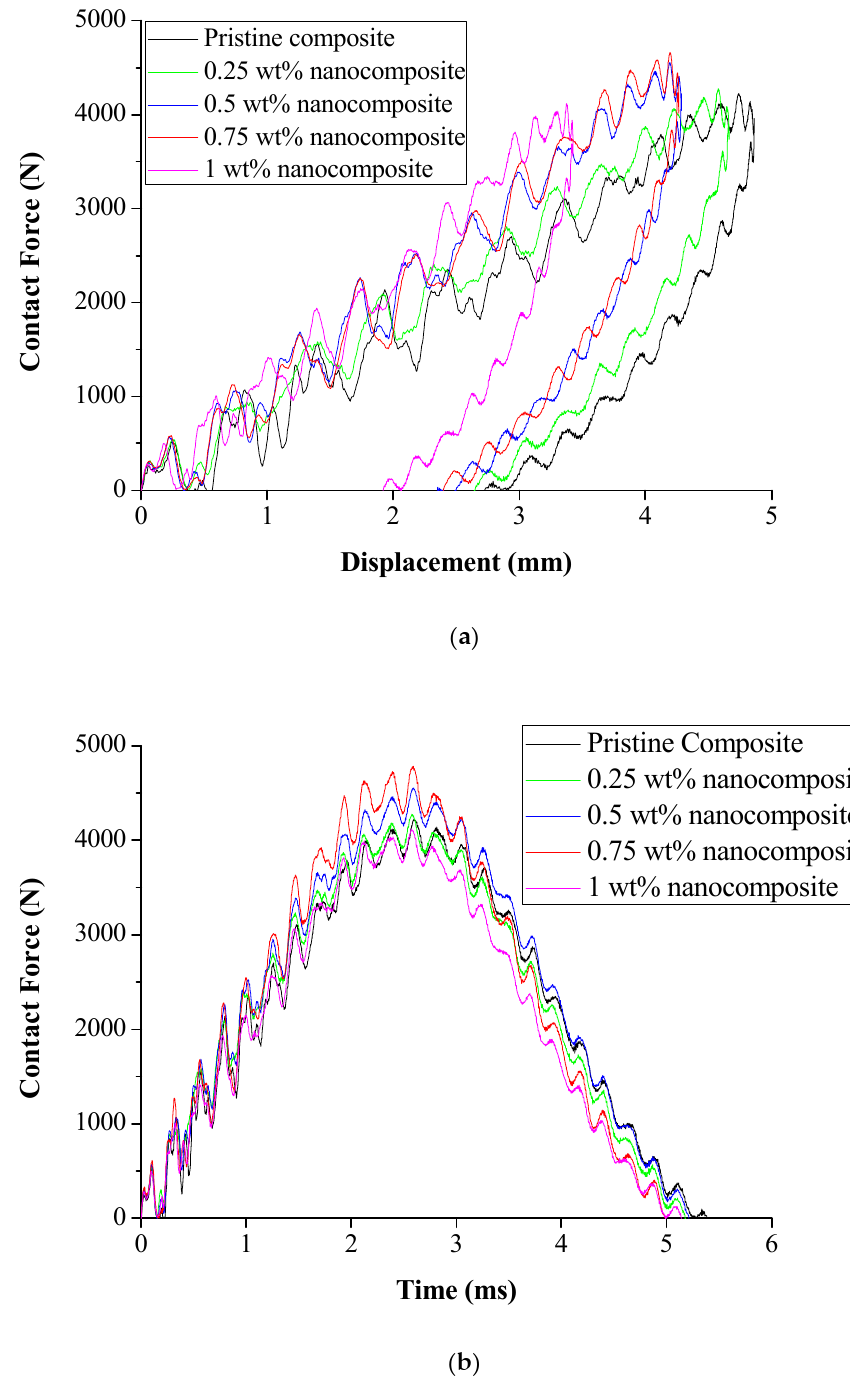
Figure 4. Responses of low-velocity impact ( a ) Contact force versus displacement behavior of composite laminates. ( b ) Contact force versus time history of composite laminates .